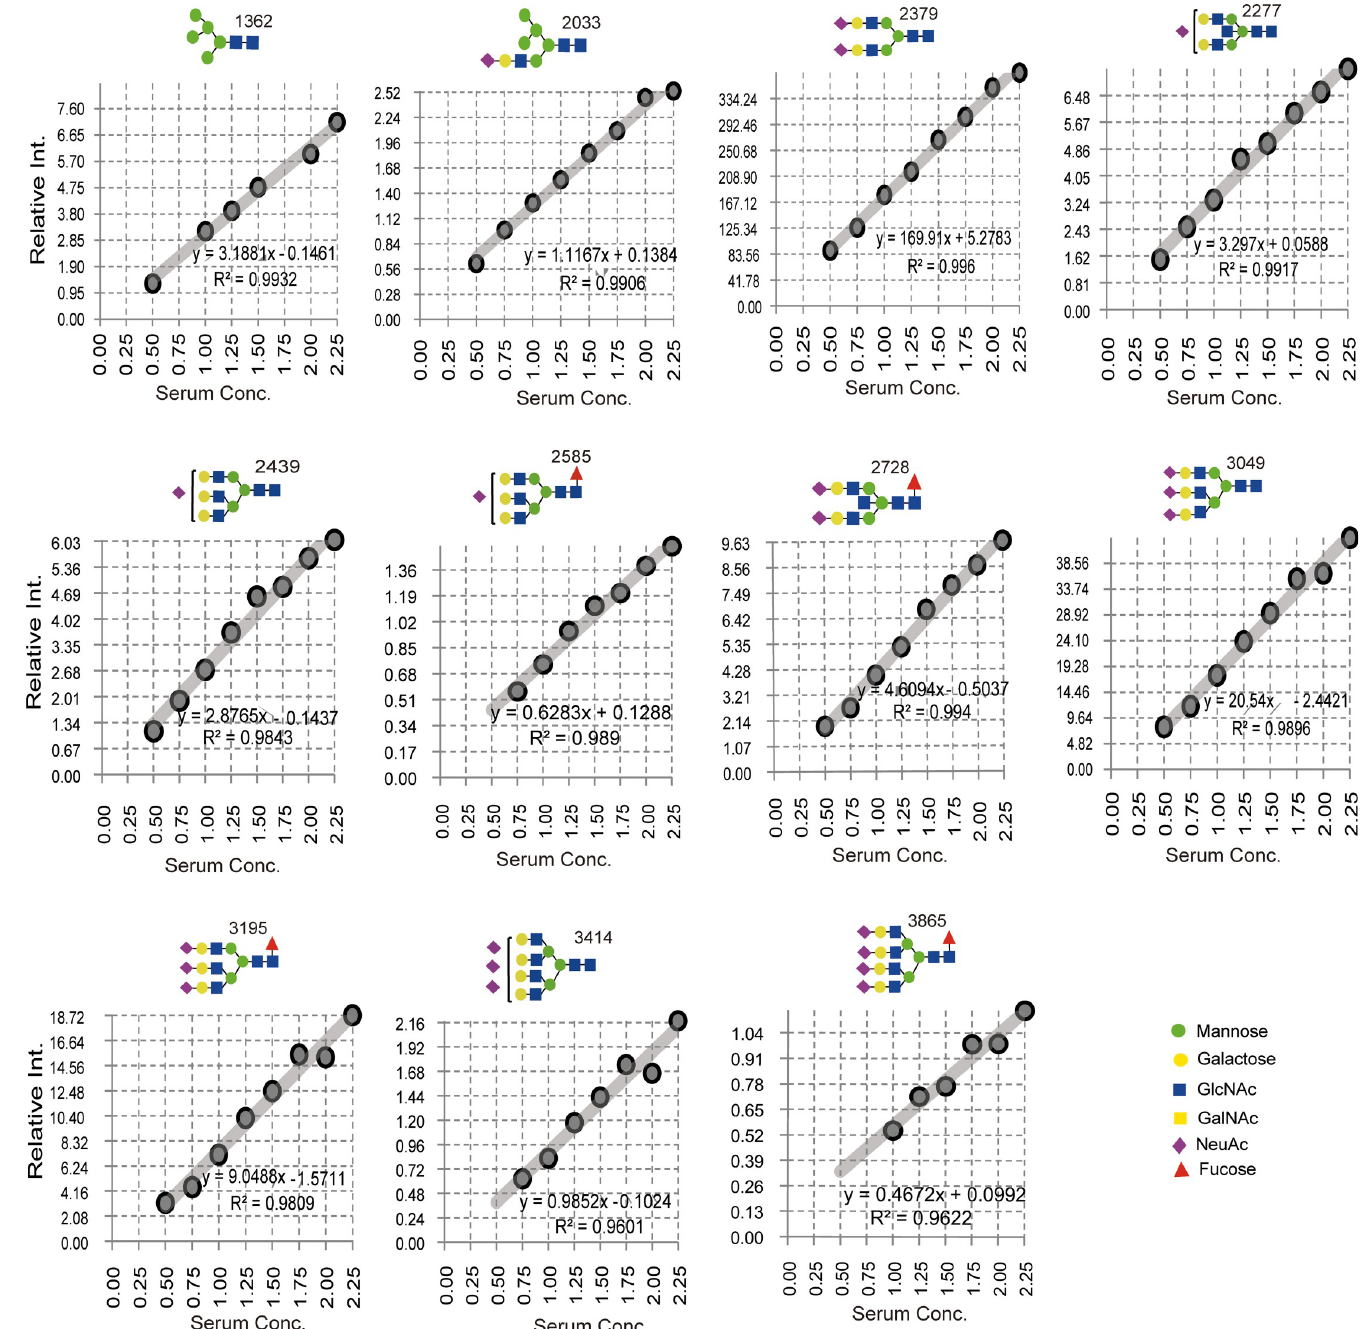
Fig 3. Human serum standard calibration curve of some common N -glycans. Glycans that have shown quantitatively reproducible detection across the various standard serum concentrations were considered and selected in the case of the main study samples. For identification purpose, individual glycans are coded or labeled by their molecular weight ( m/z value) shown near to their